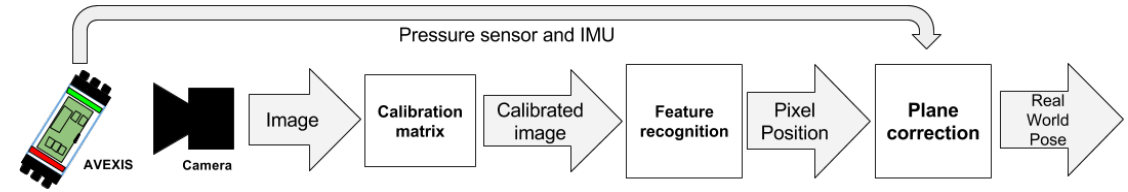
Figure 4. Flow chart of the localization system’s software steps.